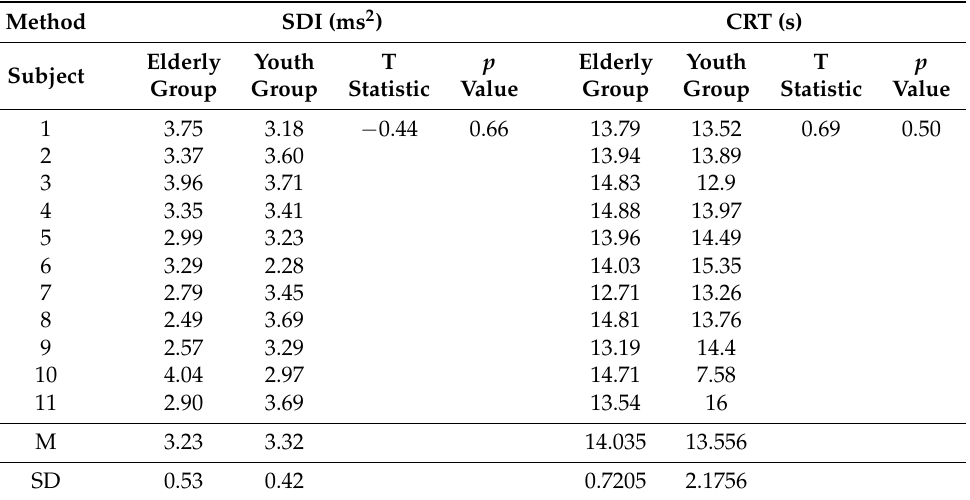
Table 4. SDI/CRT for each of the 22